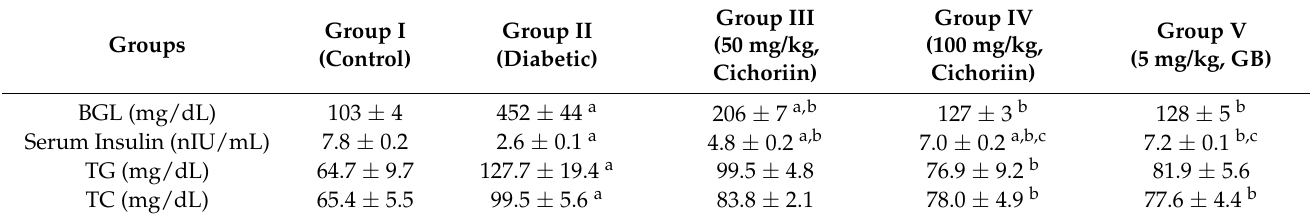
Table 1. Effect of cichoriin on biochemical parameters in rats.